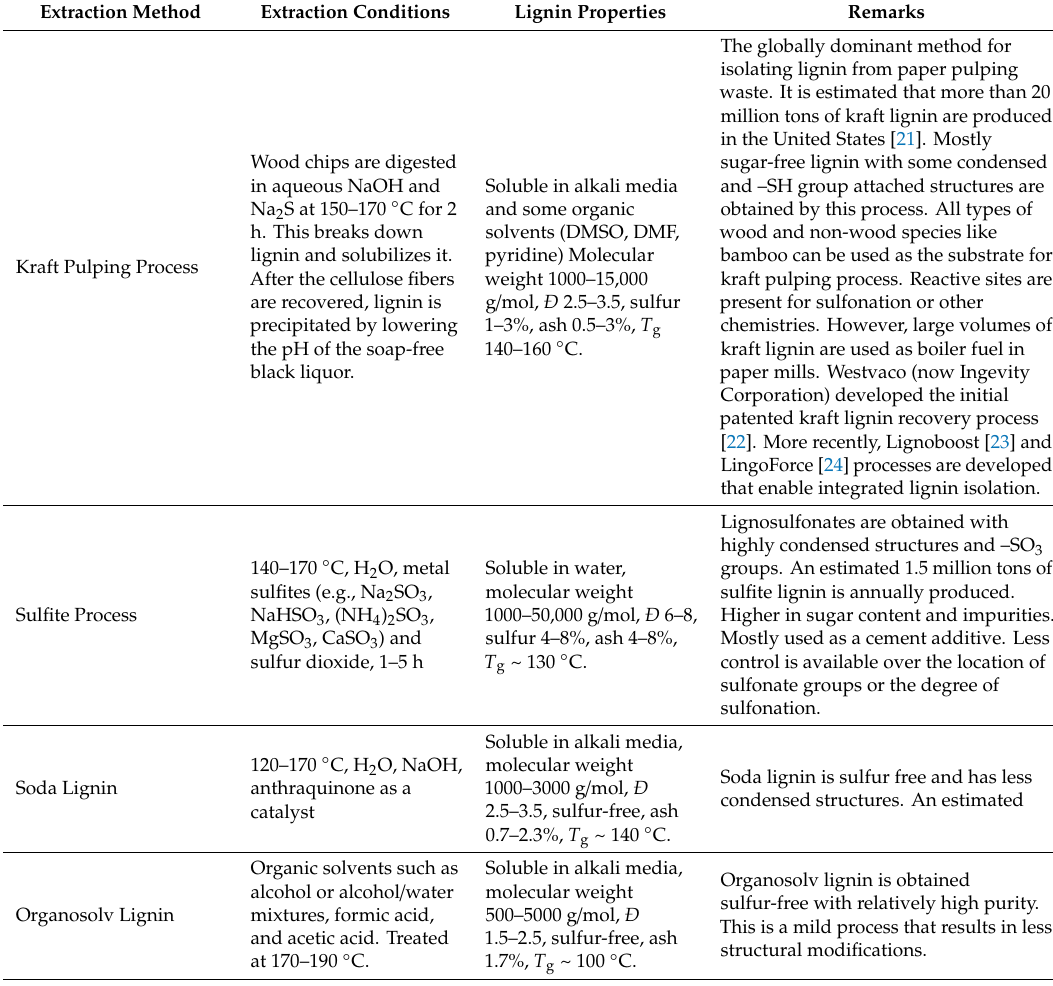
Table 1. Major extraction methods to obtain lignin or lignosulfonates. Adapted with permission